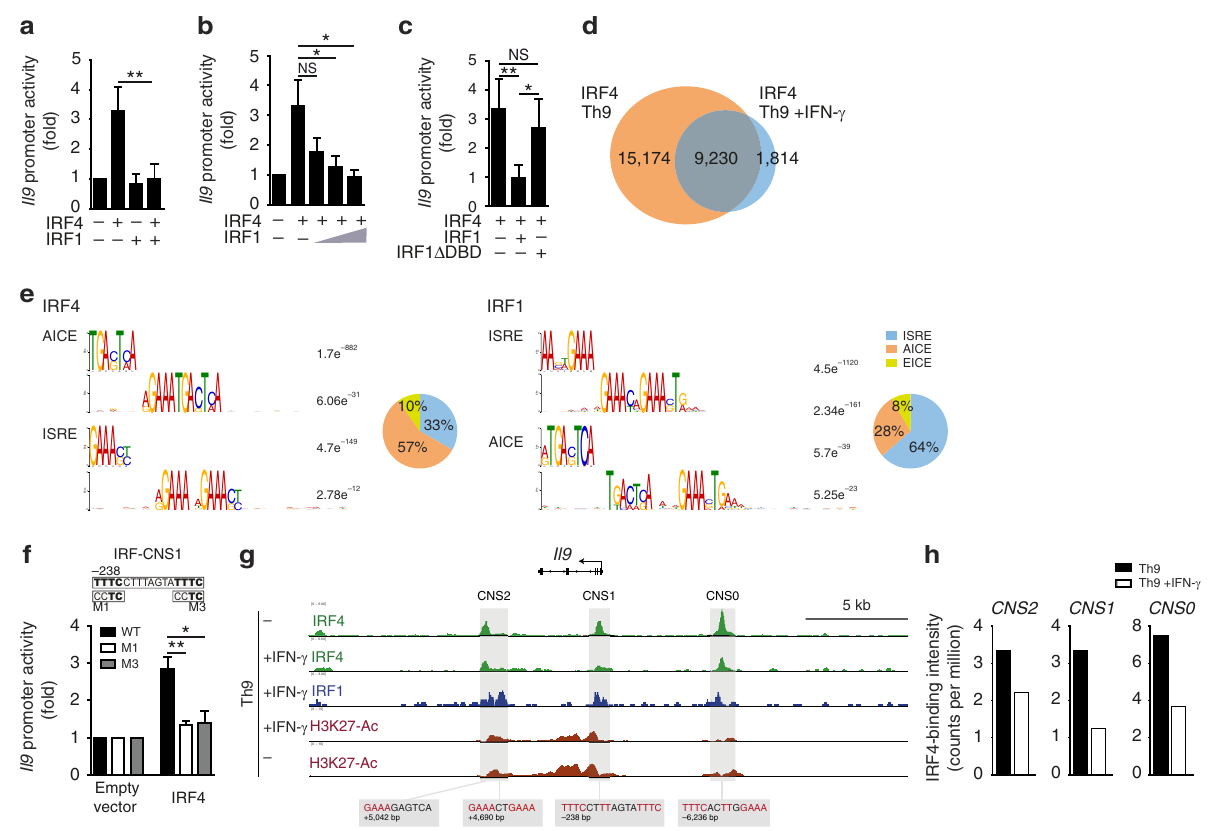
Figure 2 | Increased IRF1 binding correlates with decreased IRF4 binding at the Il9 locus. ( a – c ) Luciferase reporter assay of Th0-polarized cells transiently transfected with constant amounts of Il9 promoter-luciferase vector and with either empty vector ( (cid:2) ), IRF4-expressing vector (IRF4) and/or: ( a ) constant amounts of IRF1-expressing vector (IRF1), ( b ) increasing amounts of IRF1 (0, 0.5, 1, 2 m g) or ( c ) IRF1 or an IRF1 mutant lacking the DNA-binding domain ( D DBD). ( d , e , g , h ) ChIP-Seq analyses of Th9 cells with or without IFN- g treatment. Cells were crosslinked with formaldehyde and immunoprecipitated with the indicated antibodies. Massive parallel sequencing of immunoprecipitated DNA was performed. ( d ) Numbers in Venn diagram indicate the IRF4-binding peaks. ( e ) IRF4 binding in Th9 cells and to the right IRF1 binding in Th9 cell treated with IFN- g were analysed. Over-represented motifs shown as PWM (positional weight matrix) revealed by MEME/DREME analysis are shown. Associated piecharts indicate the frequency of designated motifs. ( f ) Non-polarized Th0 cells were transfected with either WT or the mutated M1 or M3 Il9 promoter-luciferase vectors (substitution mutation within the Il9 promoter IRF site is depicted above) together with empty vectors and/or IRF4. ( g ) ChIP-Seq analyses show IRF4 (upper lanes), IRF1 (middle lane) or H3K27-Ac (bottom two lanes) abundance. Below in grey boxes, potential IRF-binding sites are depicted including their distance from the Il9 transcription start site. ( h ) Normalized read counts from IRF4-ChIP-Seq in Th9 cells in the absence or presence of IFN- g for CNS0, 1 and 2 are shown. ( a – c , f ) Data are combined from three independent experiments and show mean ± s.d. * P o 0.05, ** P o 0.005, *** P o 0.001 (two-tailed Student’s t